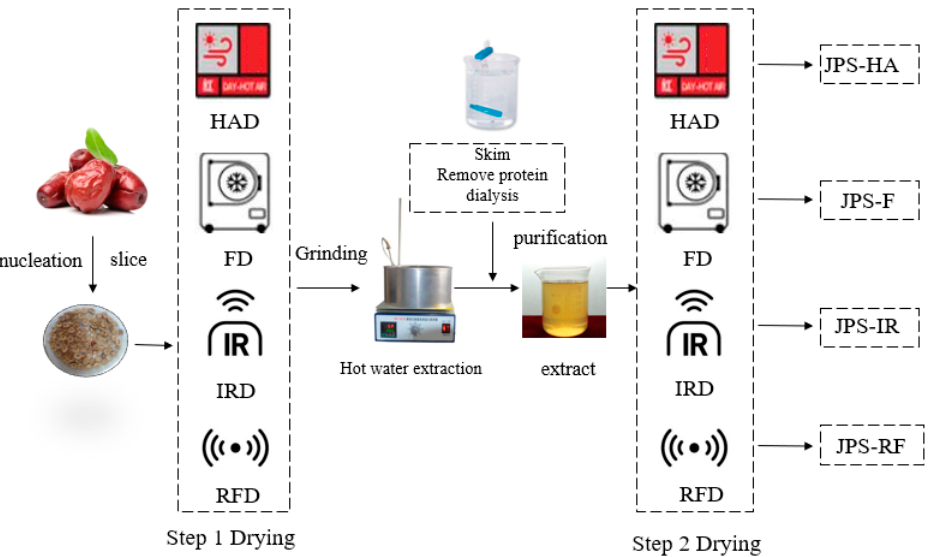
Figure 1. Schematic diagram of the two-step drying method of jujube polysaccharide extraction.